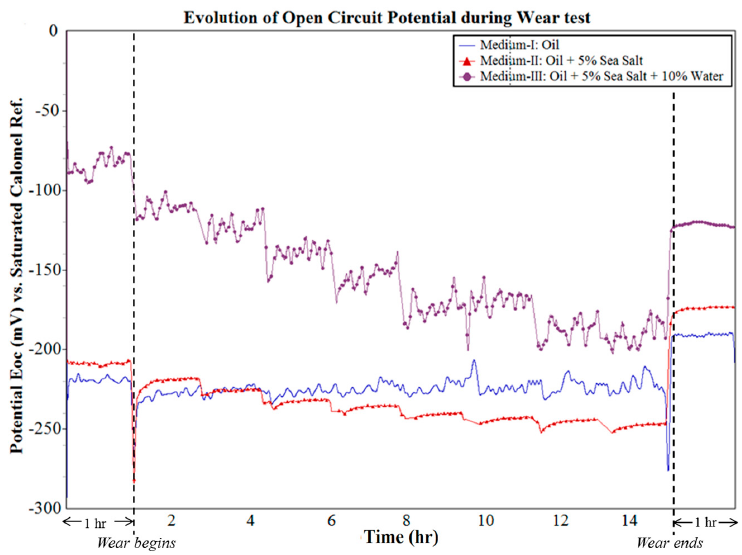
Figure 5. Evolution of OCP during wear test in different oil mediums.